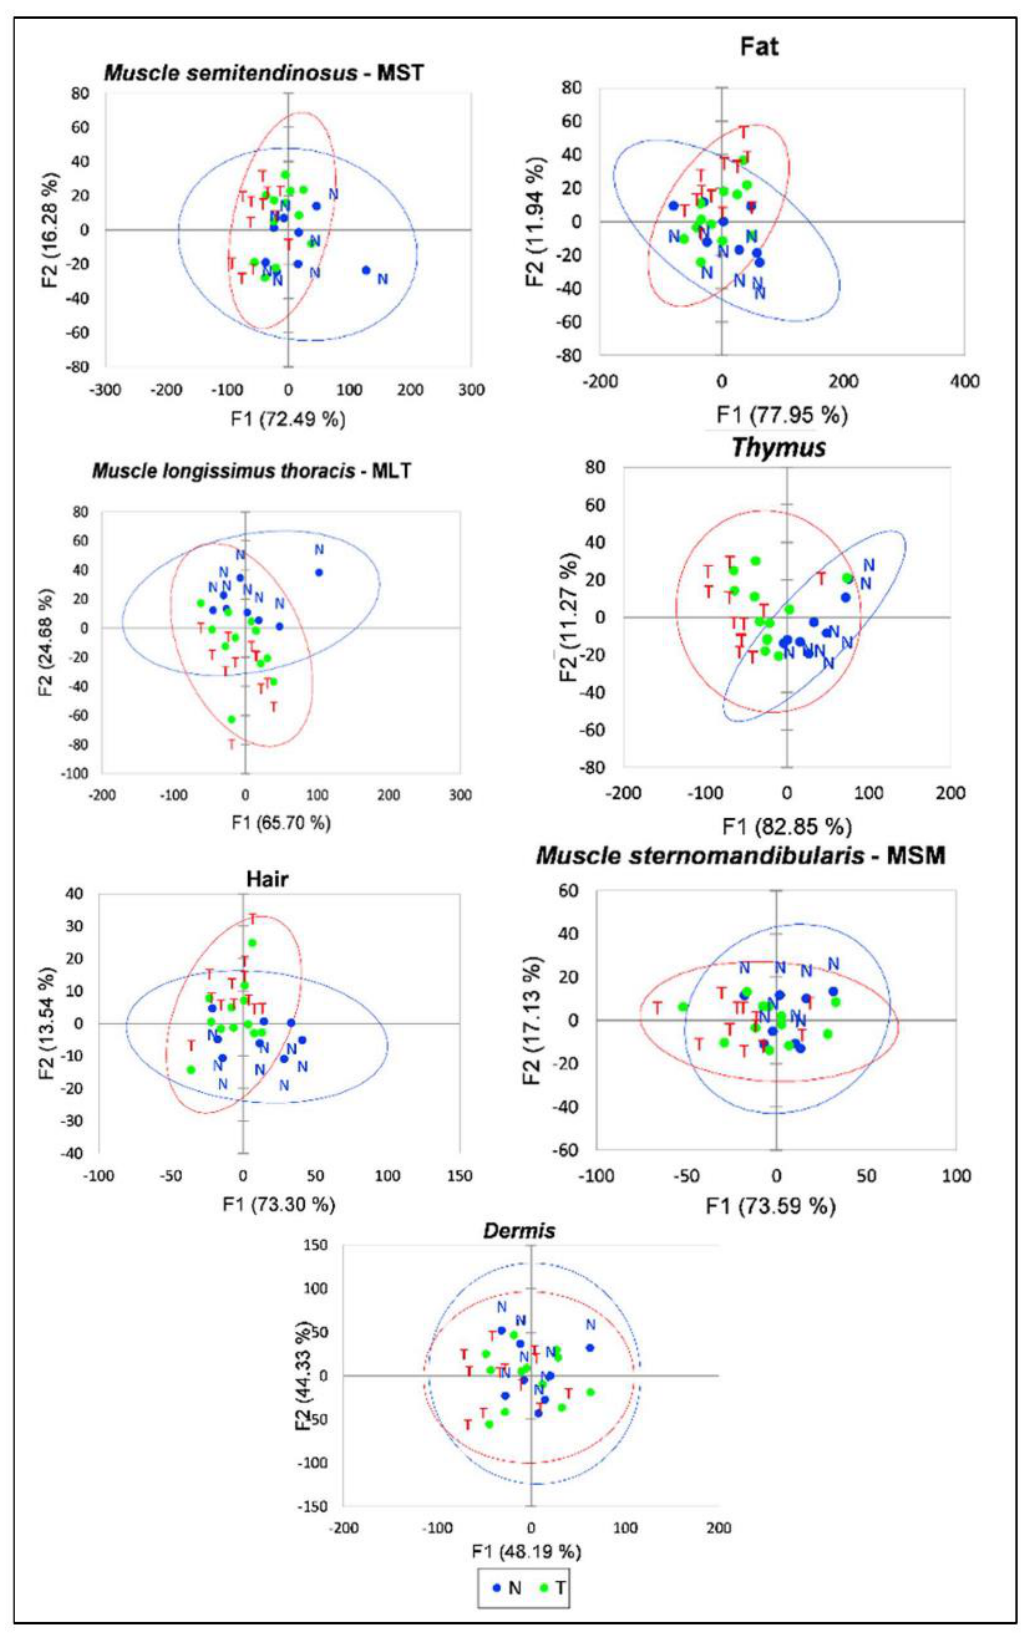
Figure 2. Principal component analyses of the full spectra for the seven tissues (N = Control; T = Treated).